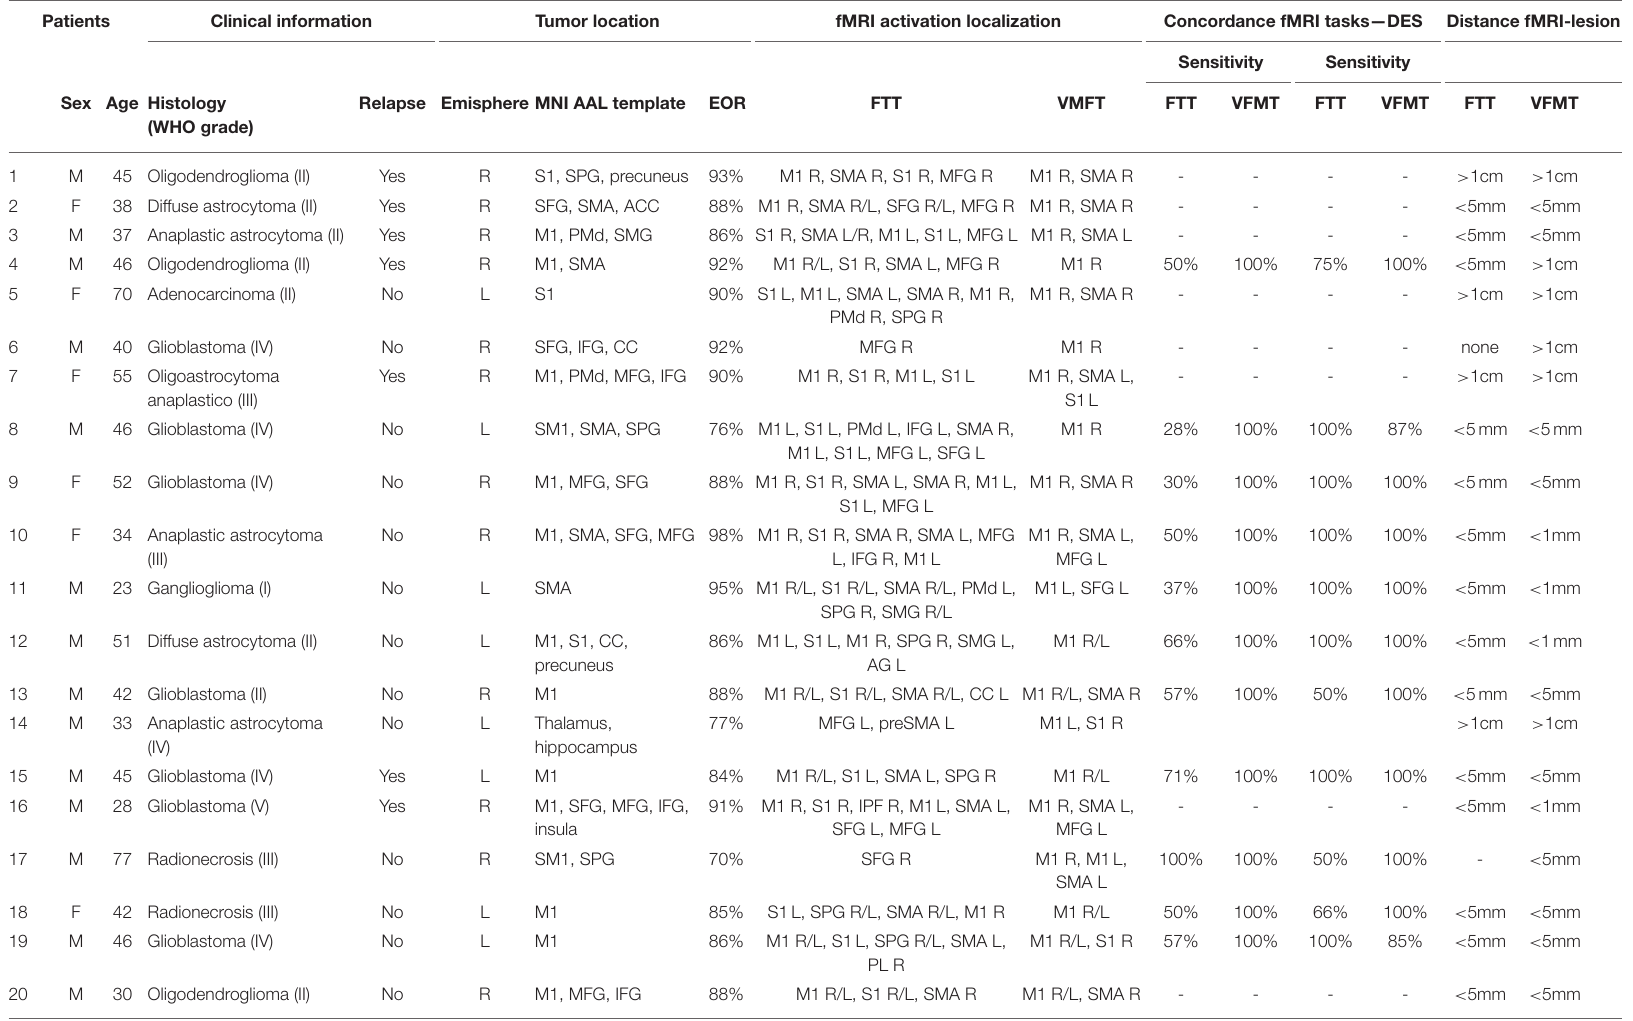
TABLE 1 | Demographic and clinical data: tumor type, localization and EOR.